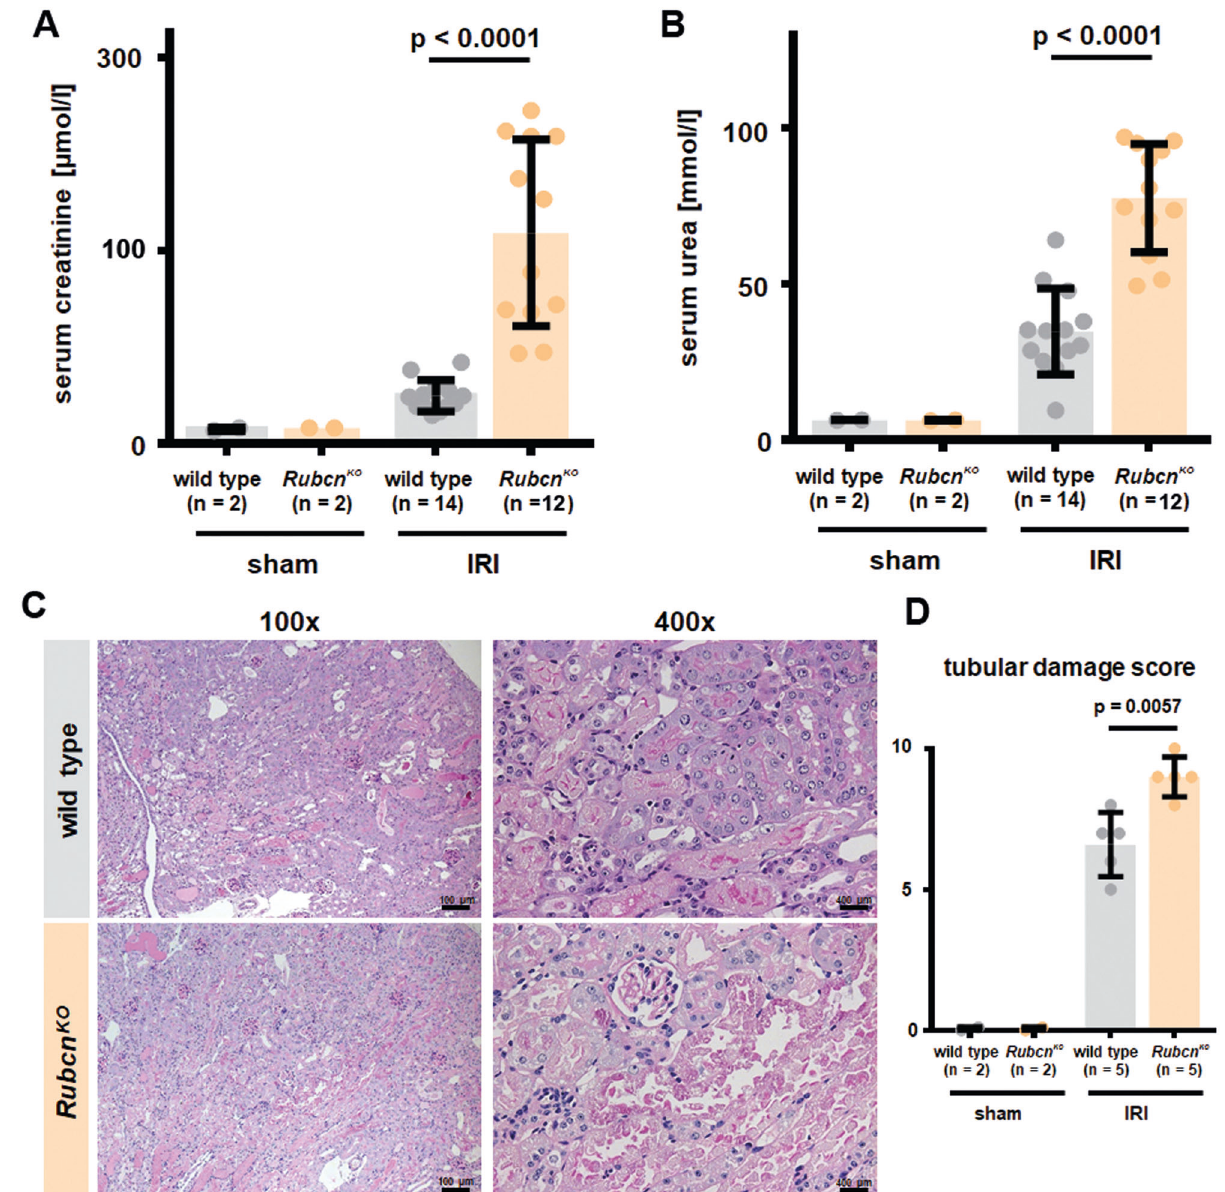
Fig. 1 RUBCN-de fi cient mice are hypersensitive to kidney ischemia-reperfusion injury (IRI). Indicated numbers of 8 – 12-weeks-old male mice were either subjected to sham surgery or underwent bilateral kidney IRI. 48 h following the onset of reperfusion, serum creatinine ( A ) and serum urea ( B ) concentrations were measured and mice were sacri fi ced. Kidneys were stained for periodic acid Schiff (PAS) and two representative magni fi cations are demonstrated in C and quanti fi ed according to an established tubular damage score in D . Statistical analysis was performed using Student ’ s t -test ( p -values are indicated for each